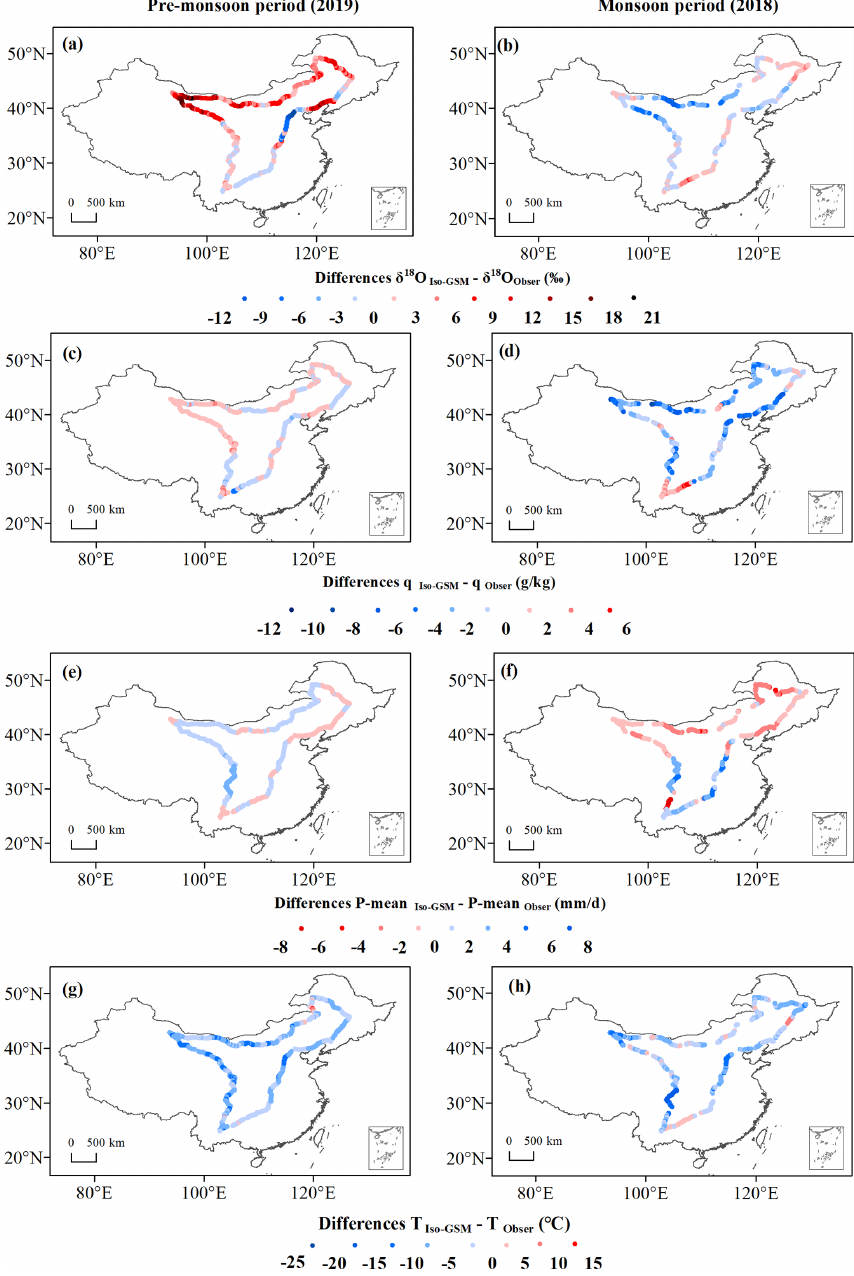
Figure 12. Spatial distribution of the differences between the outputs of Iso-GSM (subscripts are Iso-GSM) and observations (subscripts are Obser) during the pre-monsoon period (the left panel) and monsoon period (the right panel): δ 18 O ( a and b , ‰), specific humidity q ( c and d , gkg − 1 ), average precipitation amount over the entire observation period for each observation location P mean e and f , mmd − 1 ), and temperature T ( g and h , ◦ C). Note that P mean Obser are interpolated from the GPCP dataset.